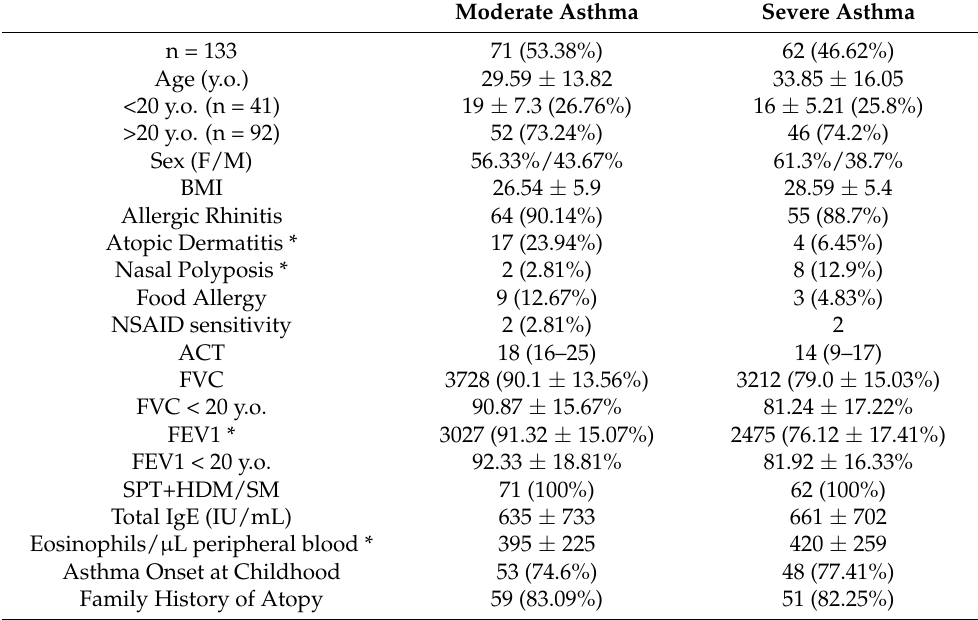
Table 1. Descriptive statistics regarding basal comorbid conditions and associated asthma features in the studied population (n = 133).